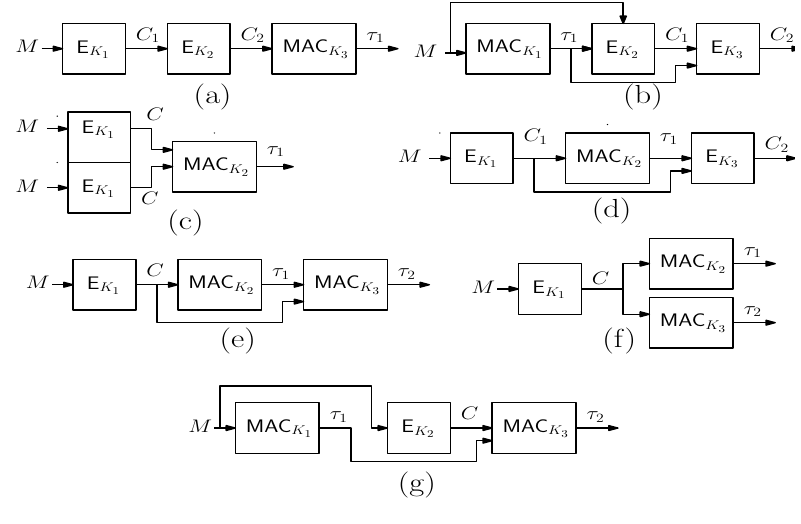
Figure 6: Alternative Three-pass